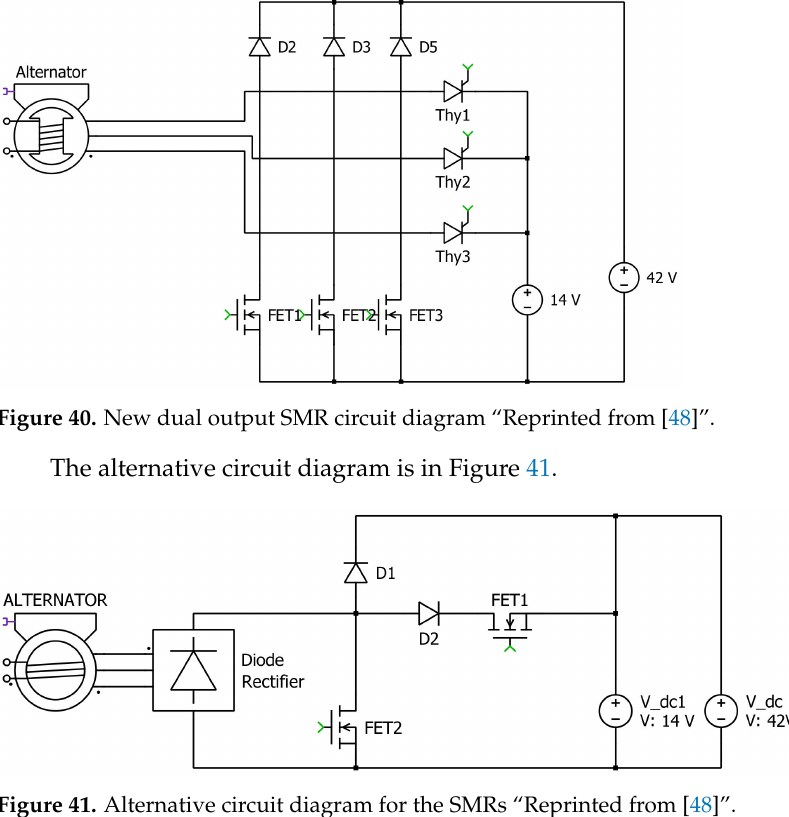
Figure 41. Alternative circuit diagram for the SMRs “Reprinted from